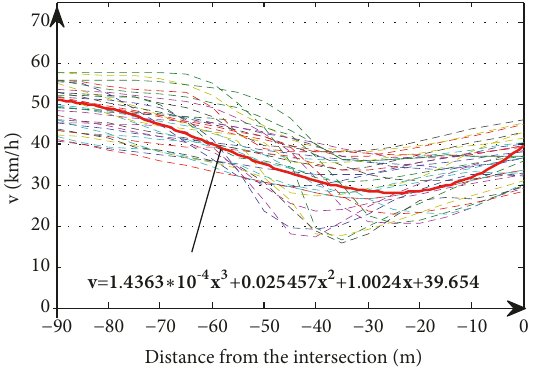
Figure 6: Velocity prediction